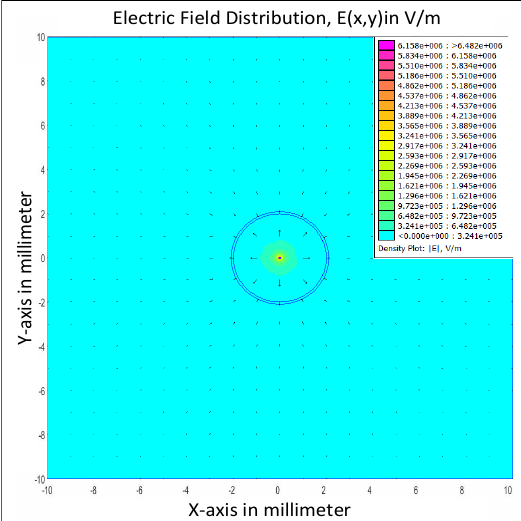
Figure 14. The electric potential distribution of the proposed device when the thin metal sheet diameter is doubled.